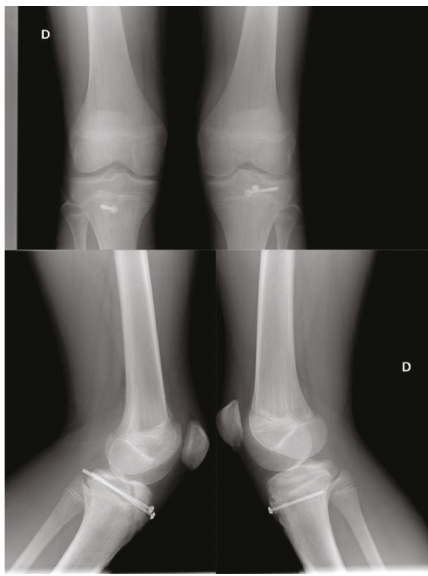
Figure 3: Plain radiographs of both knees at 6 weeks postoperative. Right knee (D) showing one 4.5 mm cannulated screw with a washer and the left one (I) two 4.5 mm cannulated screws with a washer.